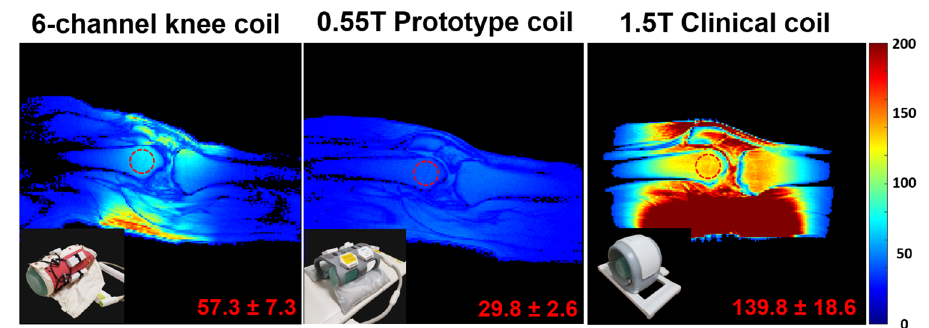
Figure 11. Representative SNR maps acquired with the 0.55 T 6-channel cable coil, 0.55 T prototype coil, and 1.5 T clinical coil. SNR values overlaid in the bottom right are averaged over three volunteers in a 3-cm ROI in the distal femur (overlaid red circles). Coil photos are inset in the bottom left of each panel.